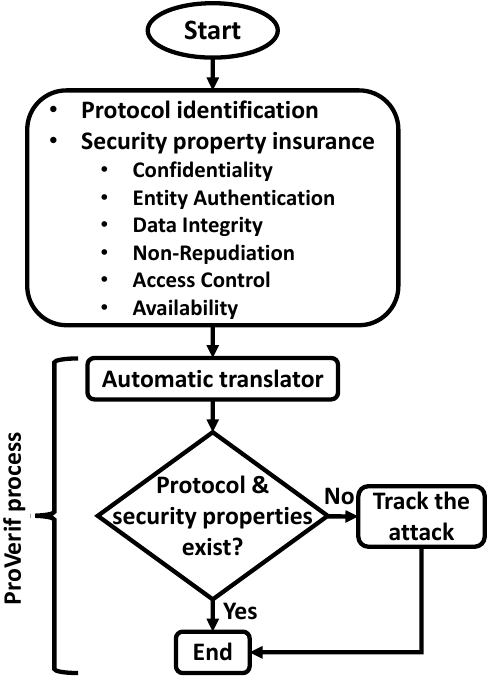
Figure 11. General structure of